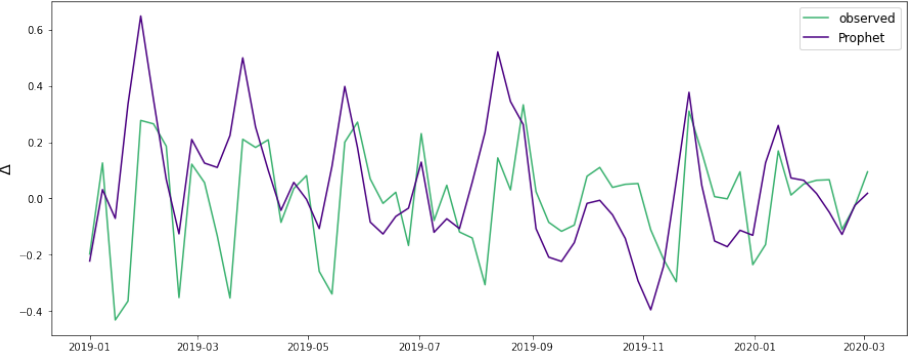
Figure 7. Comparison of Prophet forecasts and observed data for price variations in the test set, for product 2. The corresponding RMSE is